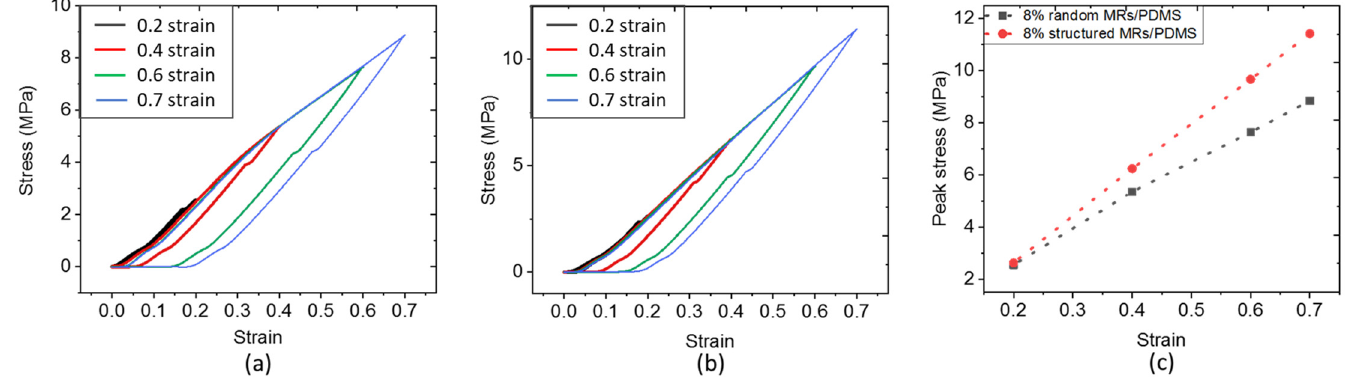
Figure 9. Compressive stress–strain curves of the 8% vol. ( a ) Random and ( b ) Structured ZnO MR/PDMS composites; ( c ) Peak stress versus strain for the 8% vol. random and structured ZnO MR/PDMS composites.